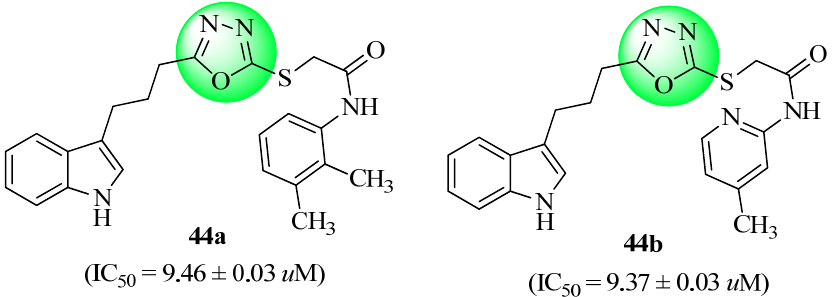
Figure 23. Derivatives of the 1,3,4-oxadiazole-2-thiol compound.